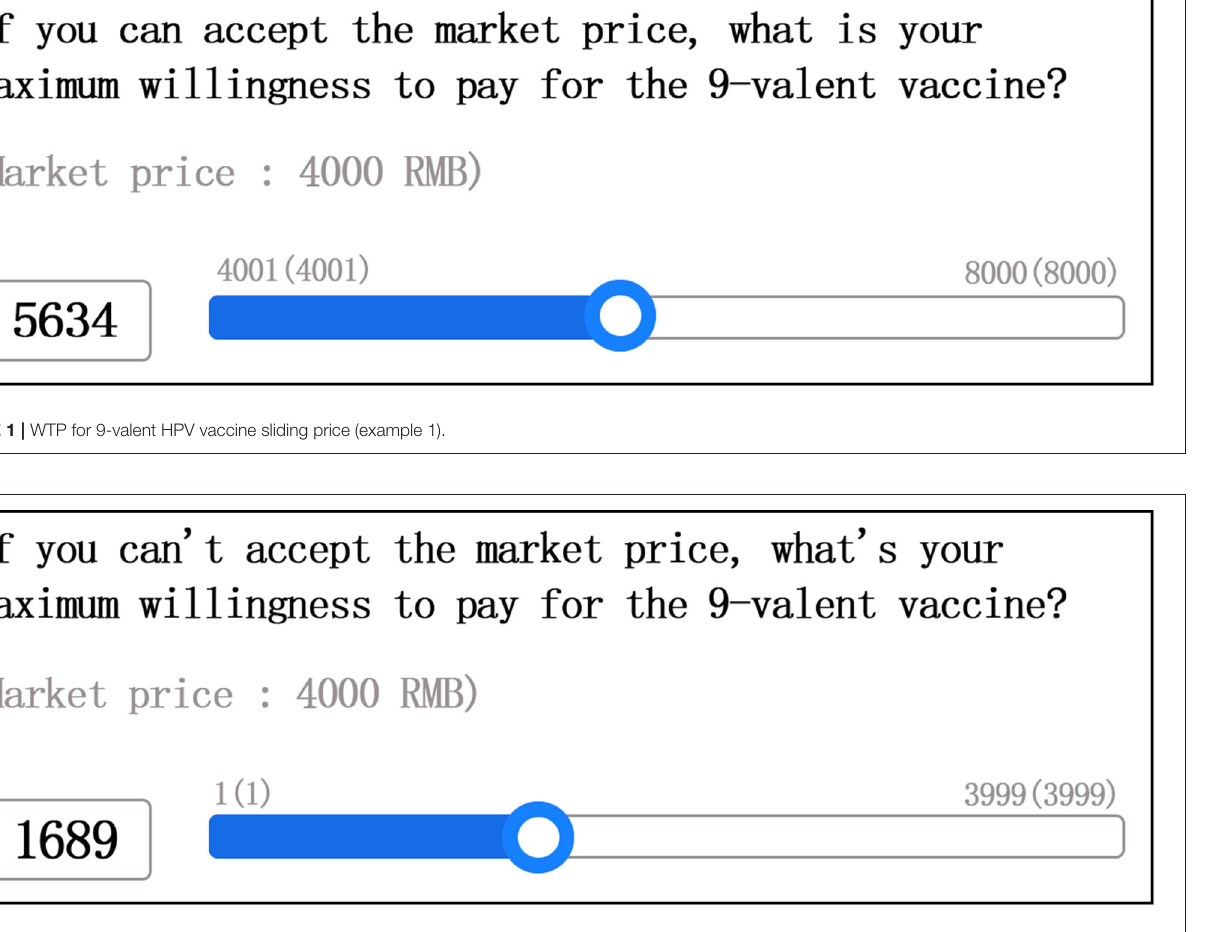
FIGURE 2 | WTP for 9-valent HPV vaccine sliding price (example